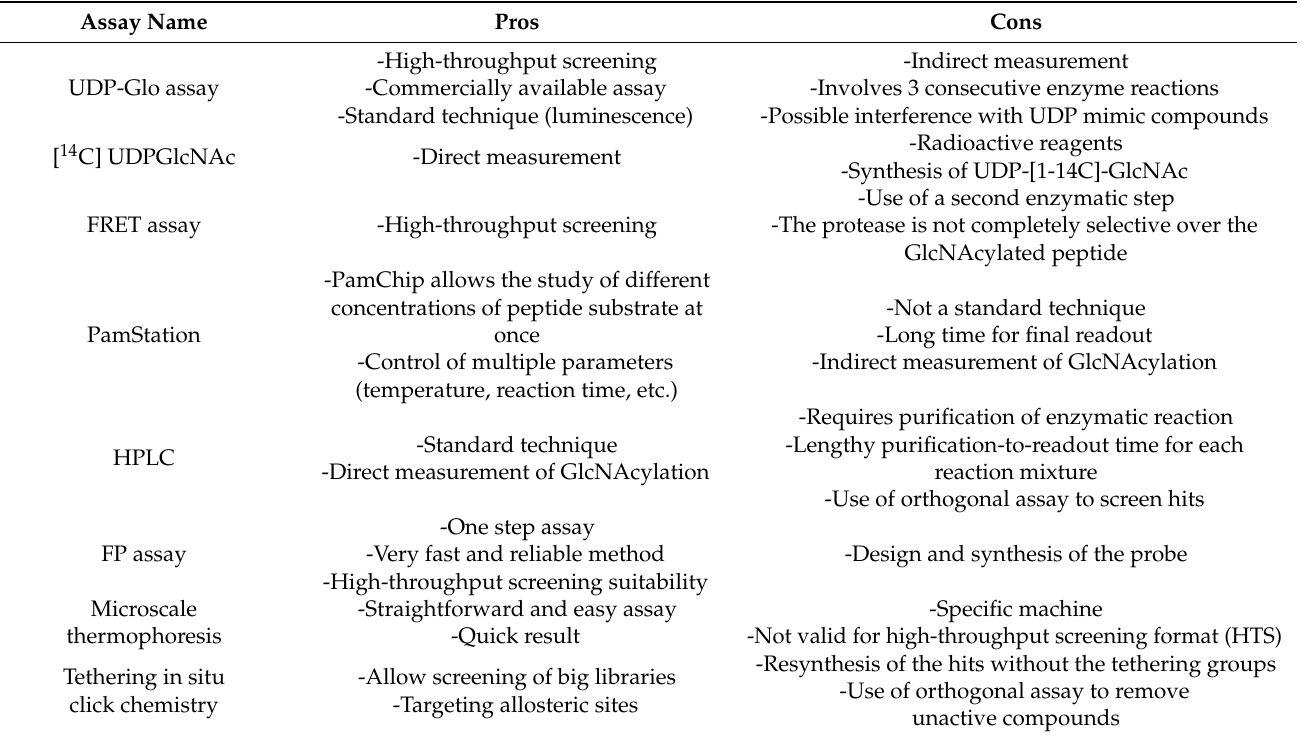
Table 1. Sum up of the pros and cons for all the bioassays mentioned in the